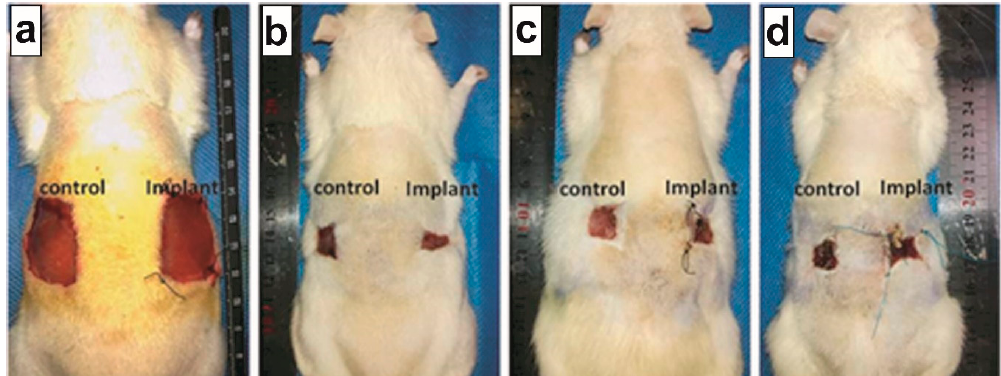
Figure 3. Wound sizes at ( a ) day 0 and ( b – d ) after 14 days of implantation. ( b ) CPR wound rate (WR) after 14 days, WR = 89%; ( c ) CP500 WR = 87%; ( d ) CP1000 WR = 81%; ( b – d ) specimens are compared with non-treatment condition (control), showing WR =